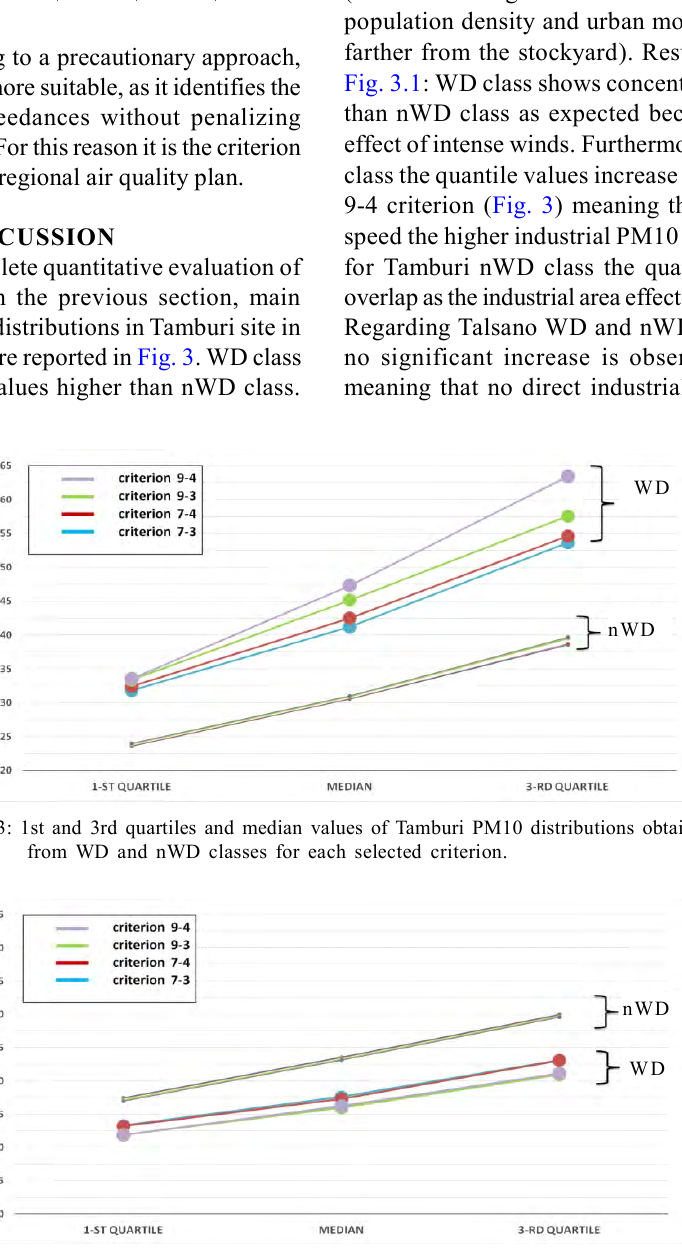
Fig. 3.1: 1st and 3rd quartiles and median values of Talsano PM10 distributions obtained from WD and nWD classes for each